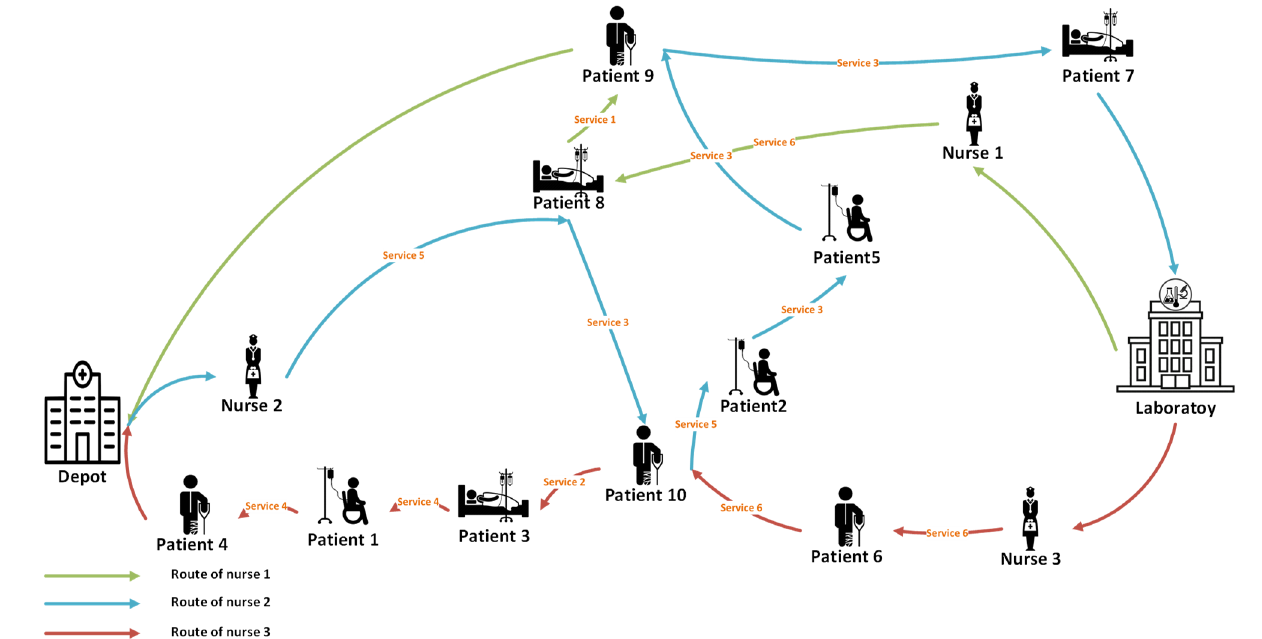
Figure 2. Optimal routes of the nurses by applying the flexible model .